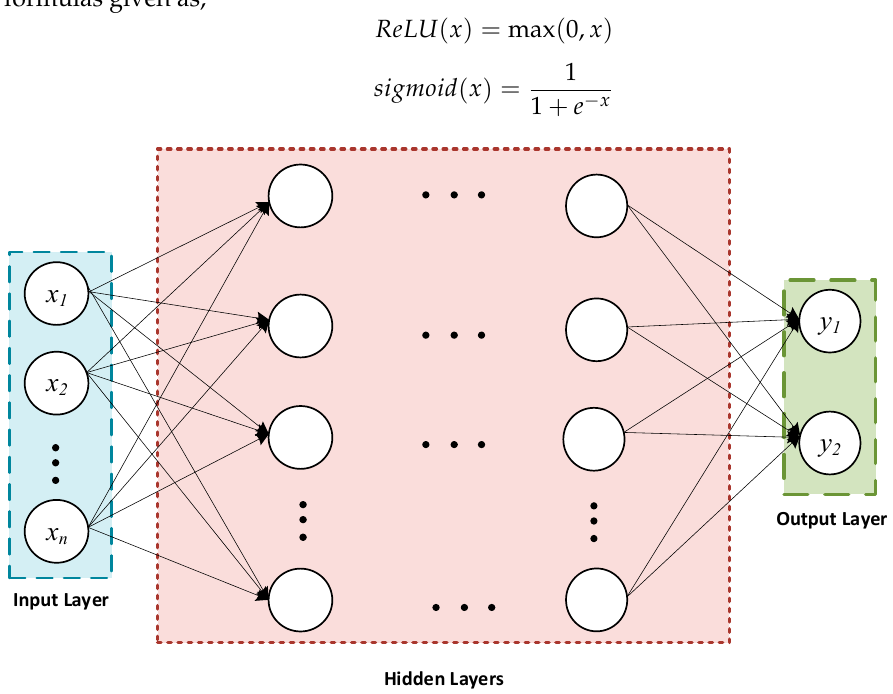
Figure 1. A general Deep Neural Network architecture.